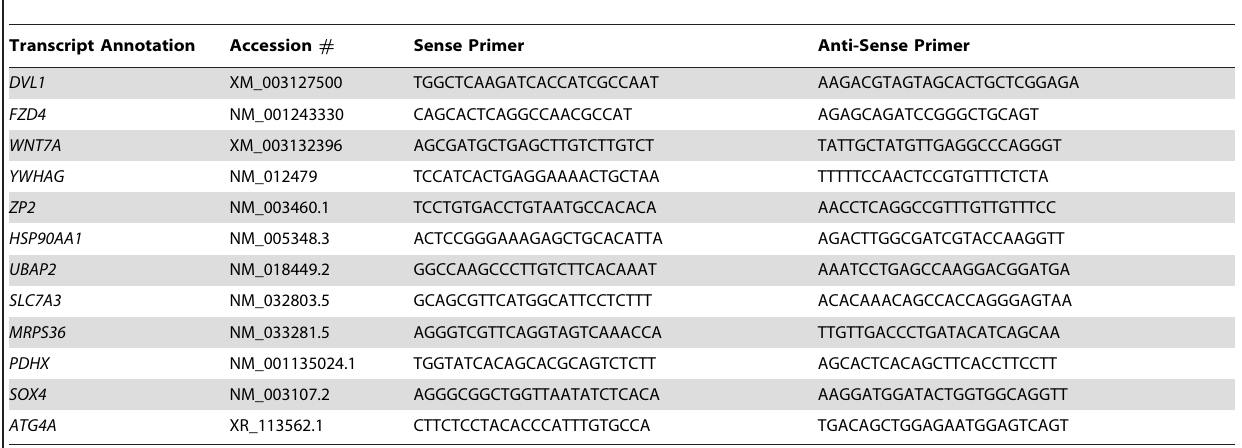
Table 4. Accession number and primer sequences used for transcript